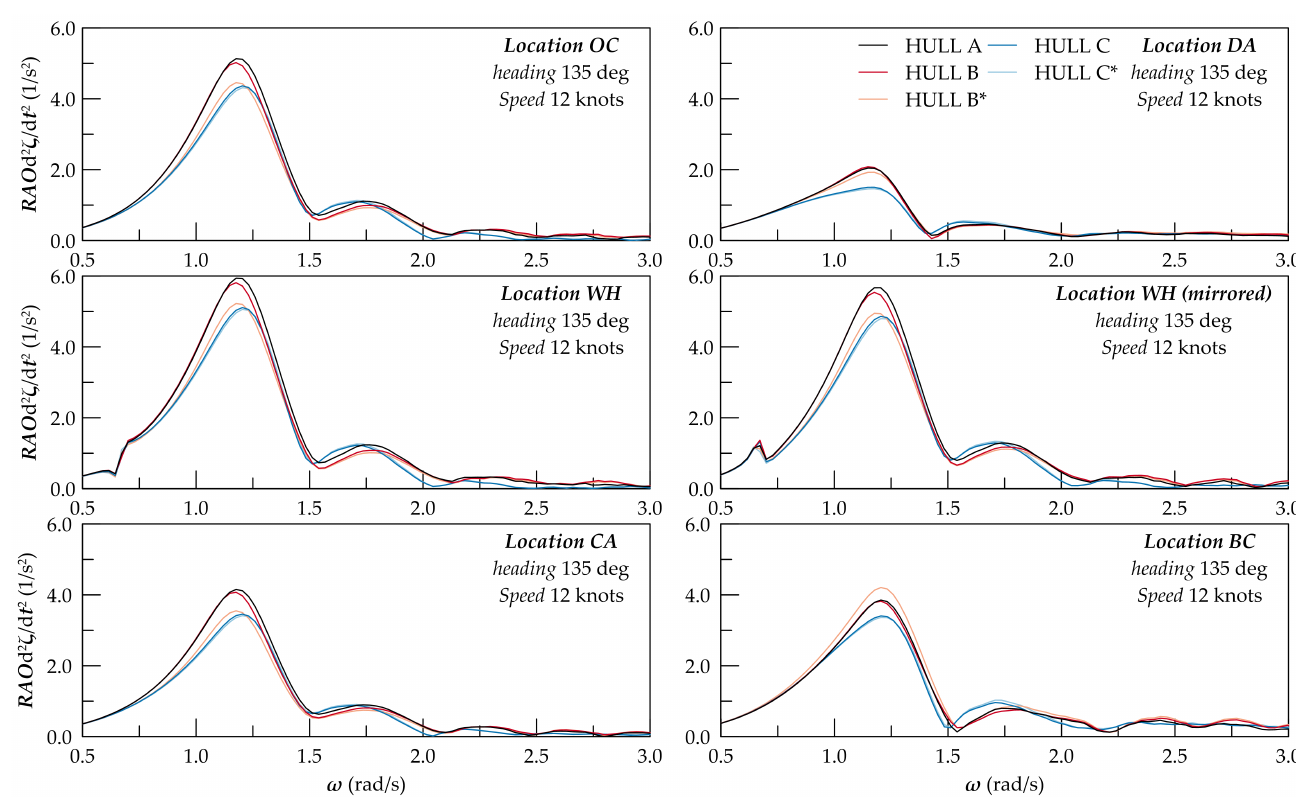
Figure 16. Absolute vertical acceleration RAO at 12 knots on the five reference hulls for the AWI